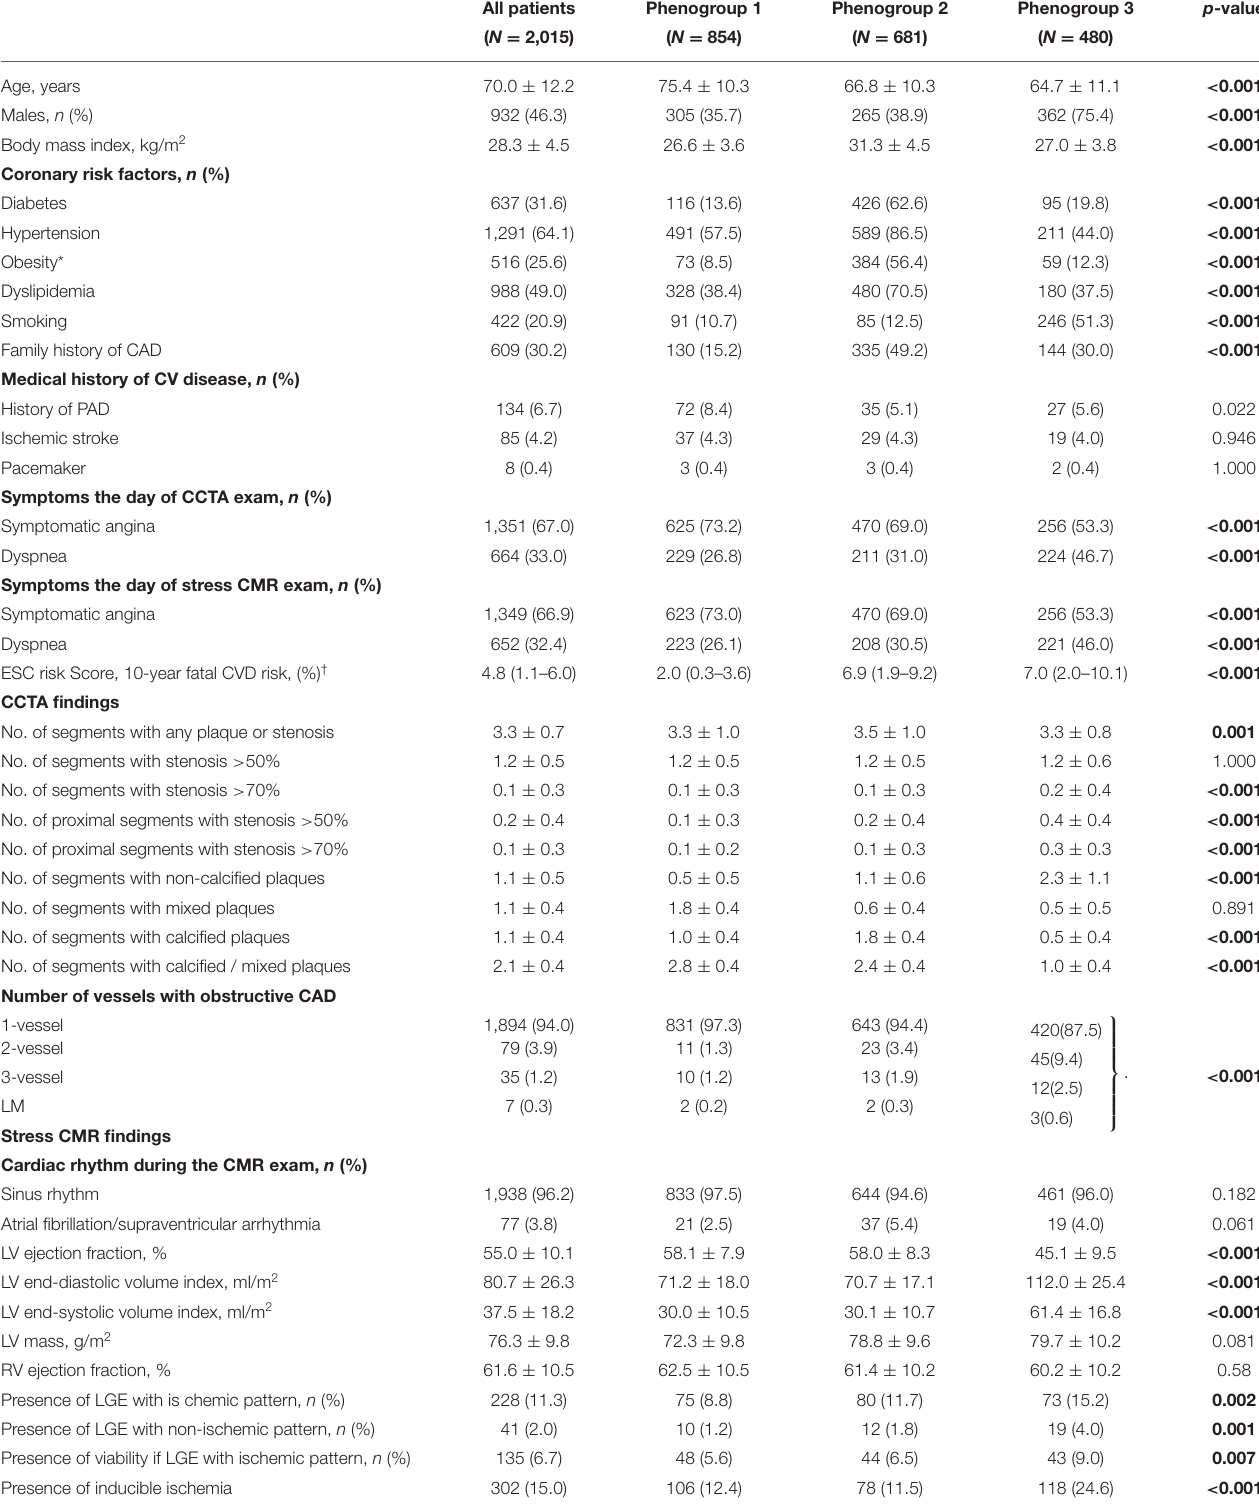
TABLE 1 | Baseline and CCTA/CMR characteristics stratified by